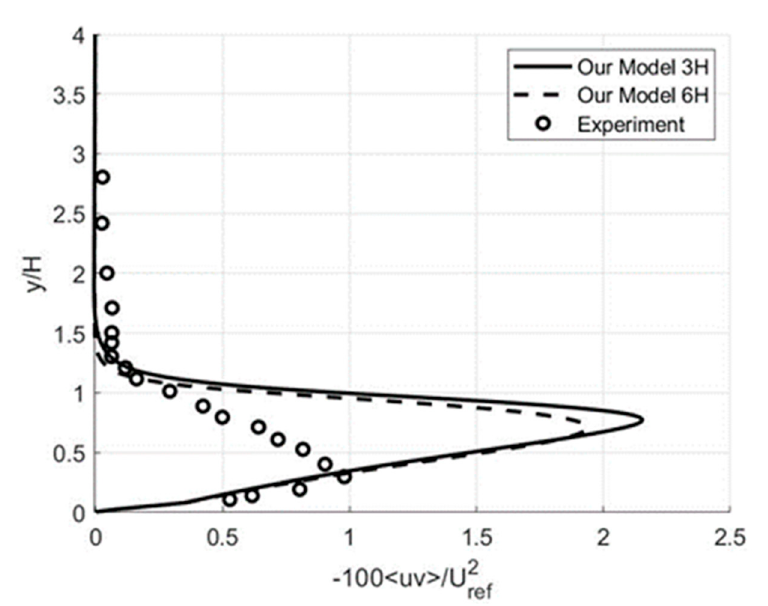
Figure 5. Mean Reynolds stress profiles at x